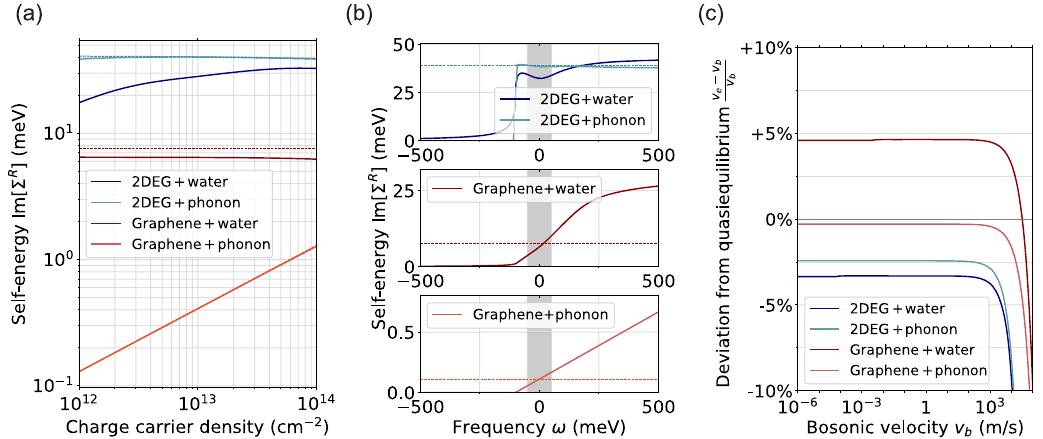
FIG. 3. Nonequilibrium self-energy. (a) Imaginary part of the electron-boson self-energy (at the Fermi level) for the four electron- boson couples discussed in the text, as a function of the charge carrier (electron or hole) density. Electron-phonon and electron-hydron scattering occur at a similar rate in the 2DEG model, whereas in graphene electron-hydron scattering is much more efficient than electron-phonon scattering. (b). Same as in (a), but plotted as a function of frequency: ω ¼ 0 corresponds to the Fermi level. The relatively weak variations within the thermal window (gray rectangle) justify the use of the impurity approximation. (c) Deviation of the effective electronic wind velocity (defined in the text) from the bosonic wind velocity, as a function of the latter ’ s